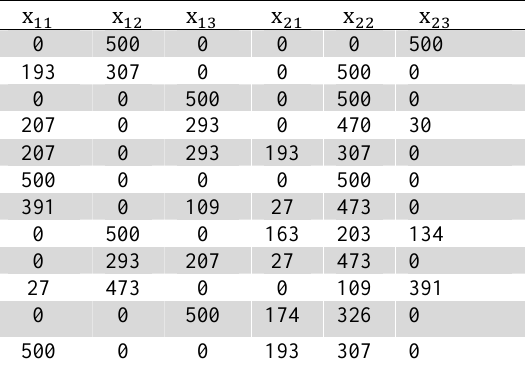
The results of some Pareto optimal solutions